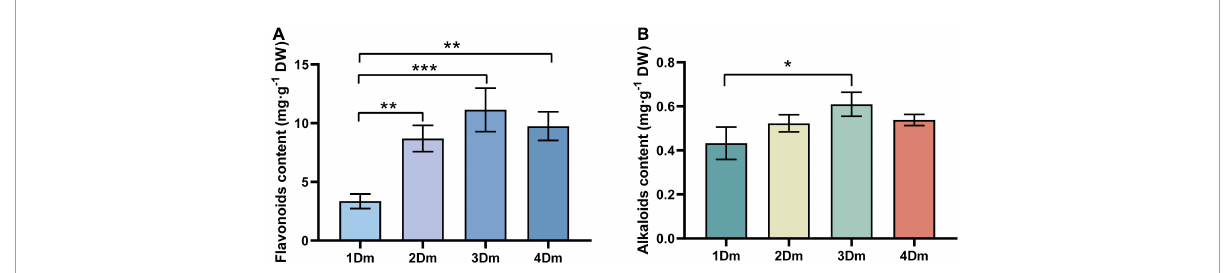
FIGURE1 Determination of total flavonoids and alkaloids in the stem of D. moniliforme . (A) Content of total flavonoids in stems of D. moniliforme with different growth years; (B) contents of total alkaloids in stems of D. moniliforme with different growth years. The asterisk “*” indicates statistical differences in the same indicator between different growth years by a t -test, with a significant difference of p < 0.05 (* p < 0.05, ** p < 0.01, *** p < 0.001). Error bars represent standard deviations ( n =